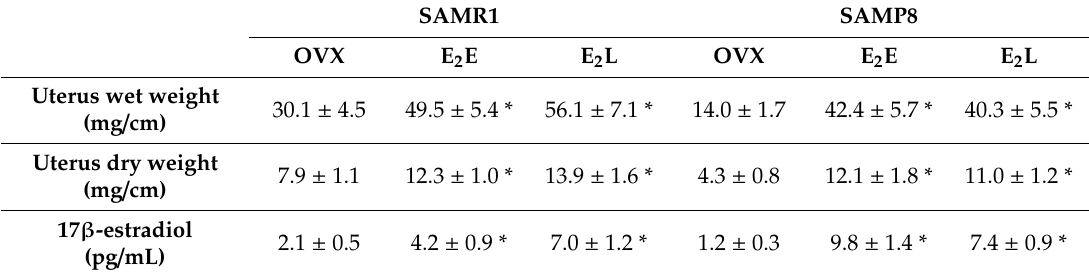
Table 1. Basic parameters (uterus weight and estrogen plasma